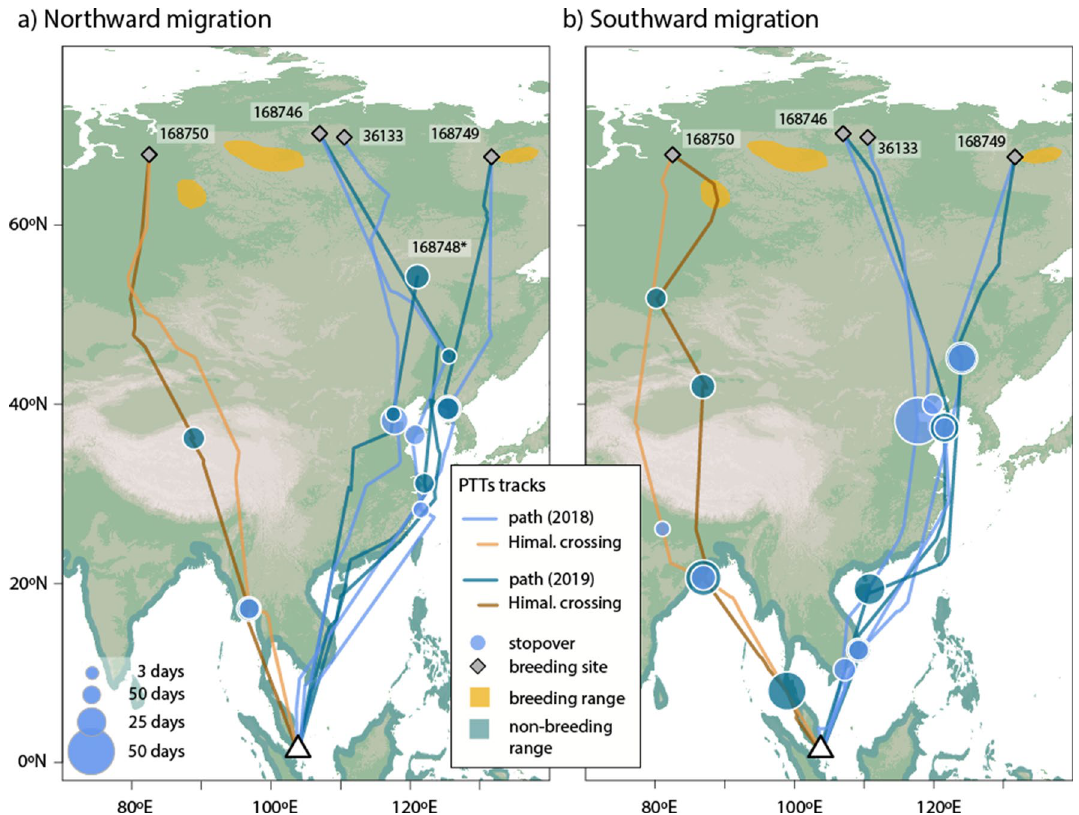
Figure 3. Migration routes of Whimbrels based on PTT satellite transmitters deployed in Singapore in 2018 and 2019. Map Source: ETOPO1 1 Arc-Minute Global Relief Model dataset provided by NOAA https ://www.